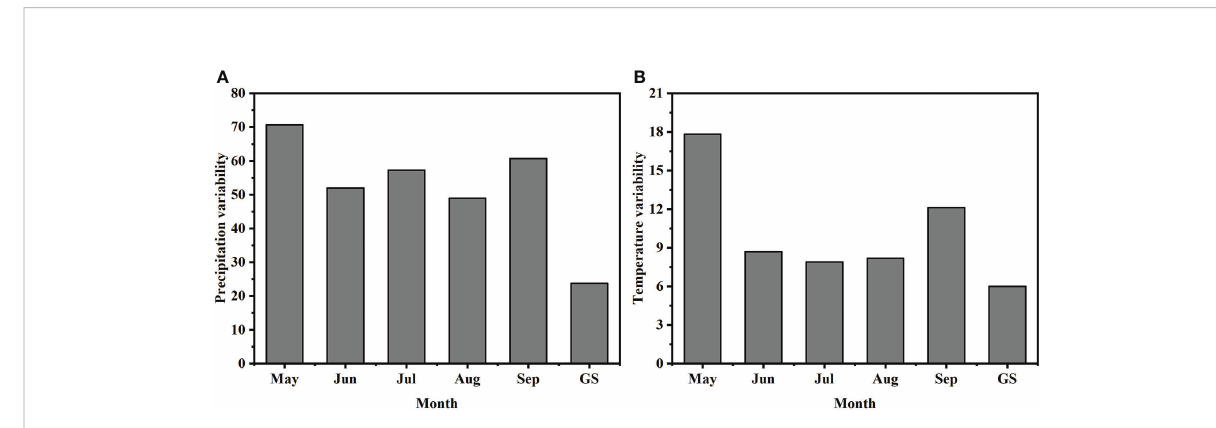
FIGURE 2 Coef fi cients of variation of monthly mean (A) precipitation and (B) temperature over 1981 – 2011. GS = growing season.